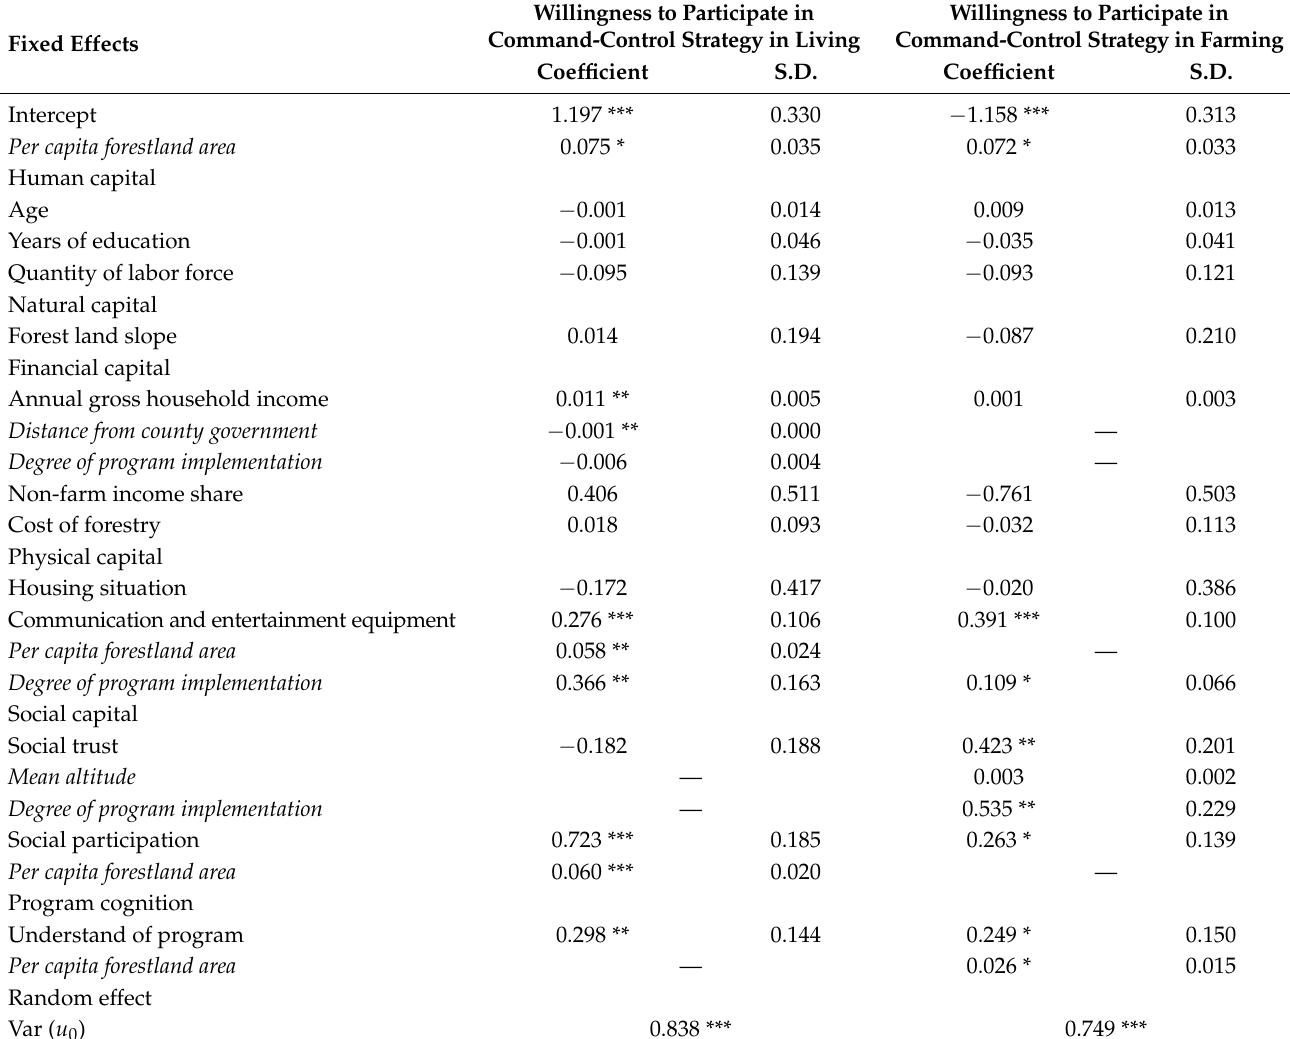
Table 6. The full model results of command-control